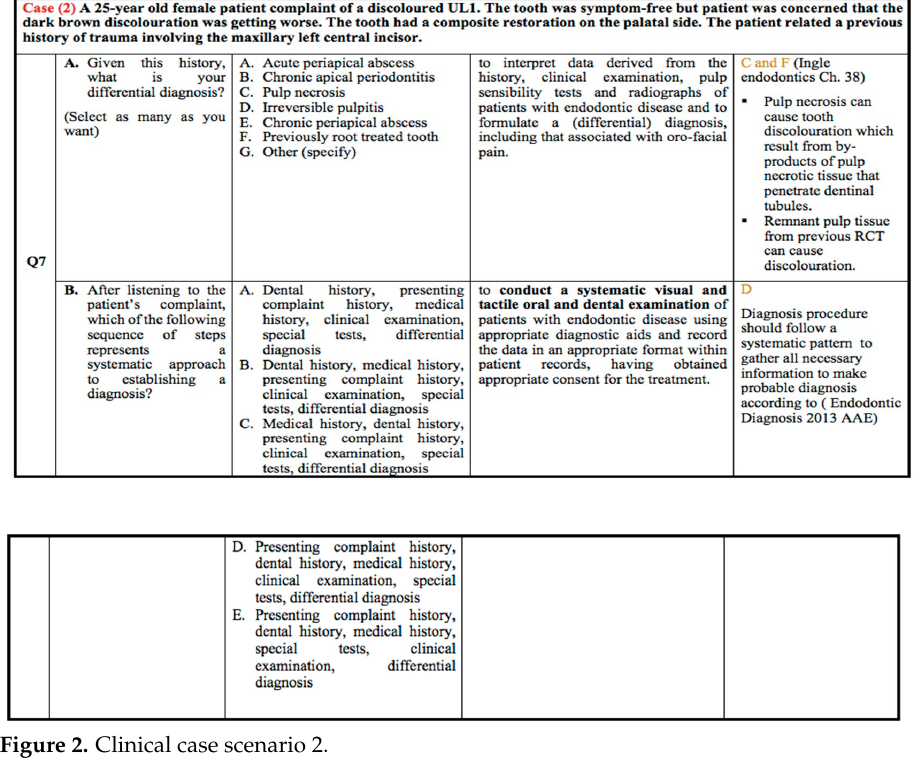
Figure 2. Clinical case scenario 2.